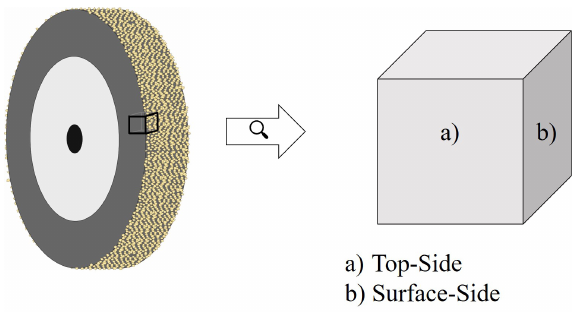
Figure 3. Grinding wheel cut-out used for